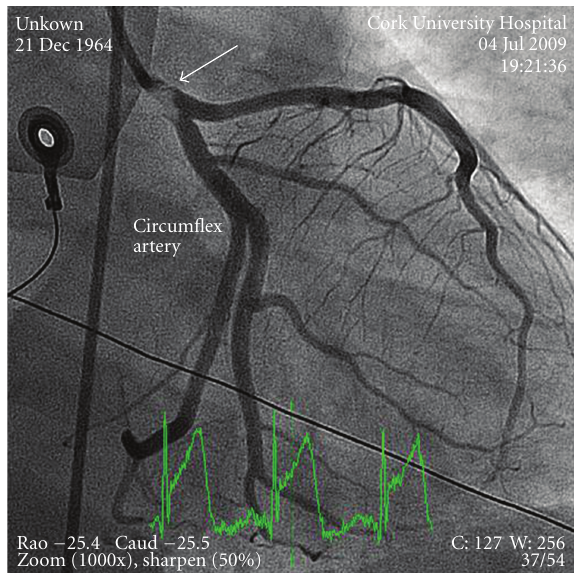
Figure 1: Right anterior oblique with caudal angulation showing the left main coronary artery full of thrombus (arrow), circumflex, and left anterior descending artery.